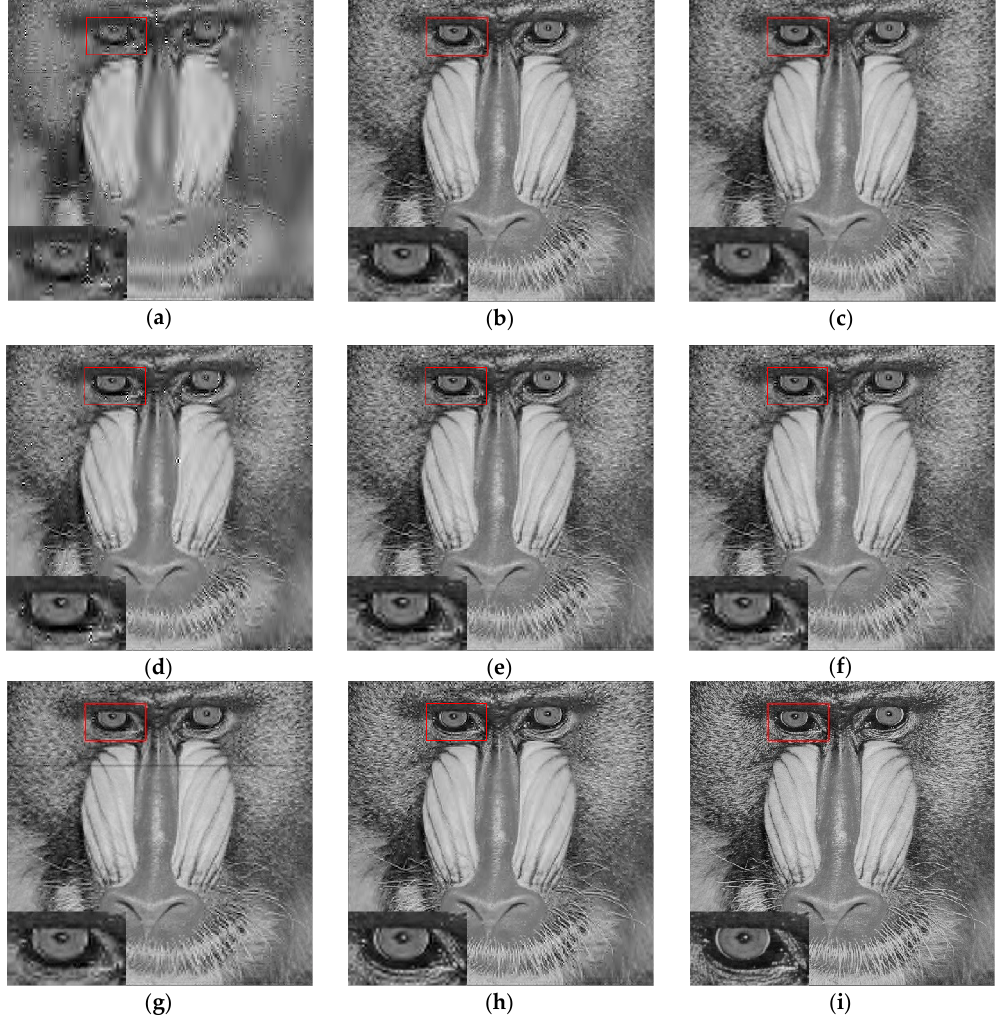
Figure 5. Reconstruction results of different arithmetic of ( a ) SP, ( b ) IRLS, ( c ) OMP, ( d ) ROMP, ( e ) GOMP, ( f ) L1_BP, ( g ) L1_LS, ( h ) L0GP, ( i ) Original Mandrill image. ( f ) L1_BP, ( g ) L1_LS, ( h ) L0GP, ( i ) Original Mandrill